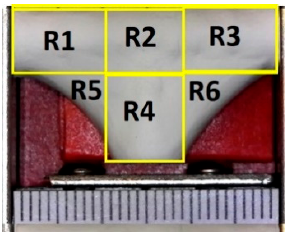
Figure 7. Definition of measurement regions for corner profile fidelity—each mark on the scale is 1 mm.